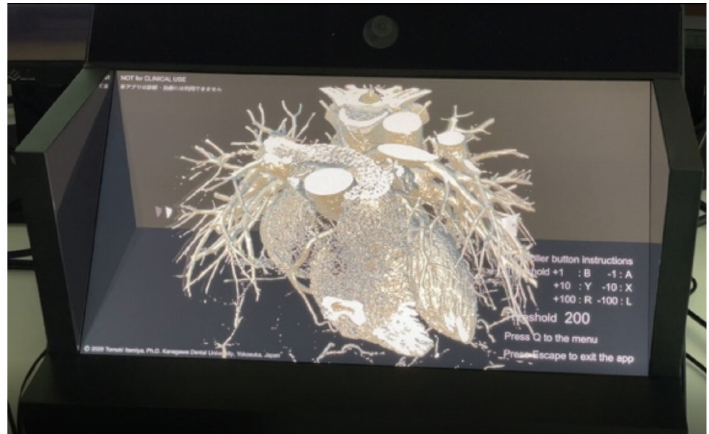
Figure 6. Example of DSR View (CT).